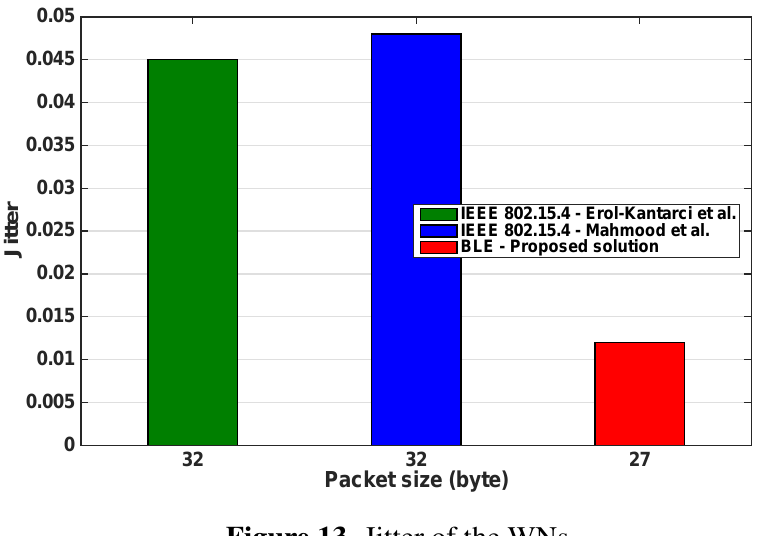
Figure 13. Jitter of the